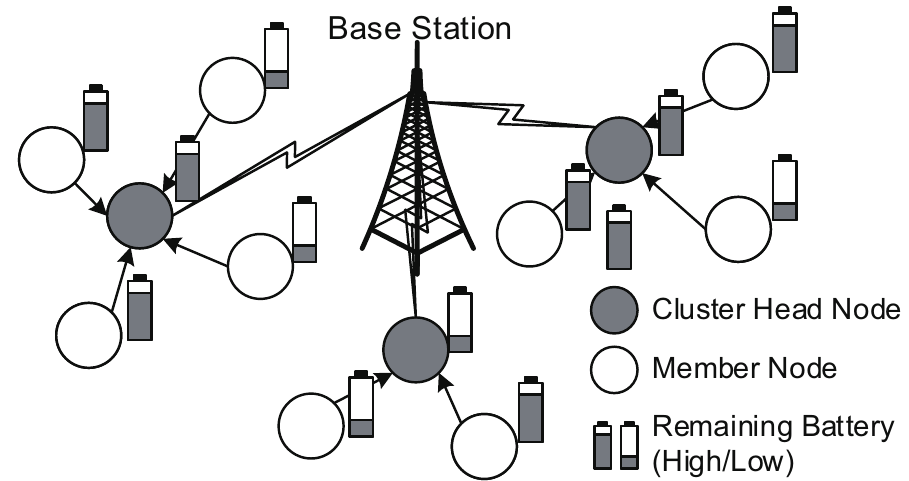
Figure 1. A battery-powered wireless sensor network (WSN) with low-energy adaptive clustering hierarchy